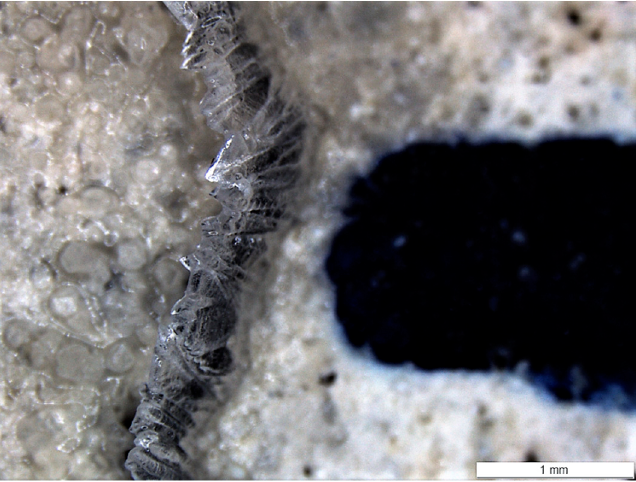
Figure 12. Crack location on the bottom faces of a specimen subjected to W/D cycles ( a : initial, b : 3 weeks of healing, and c : 6 weeks of healing).